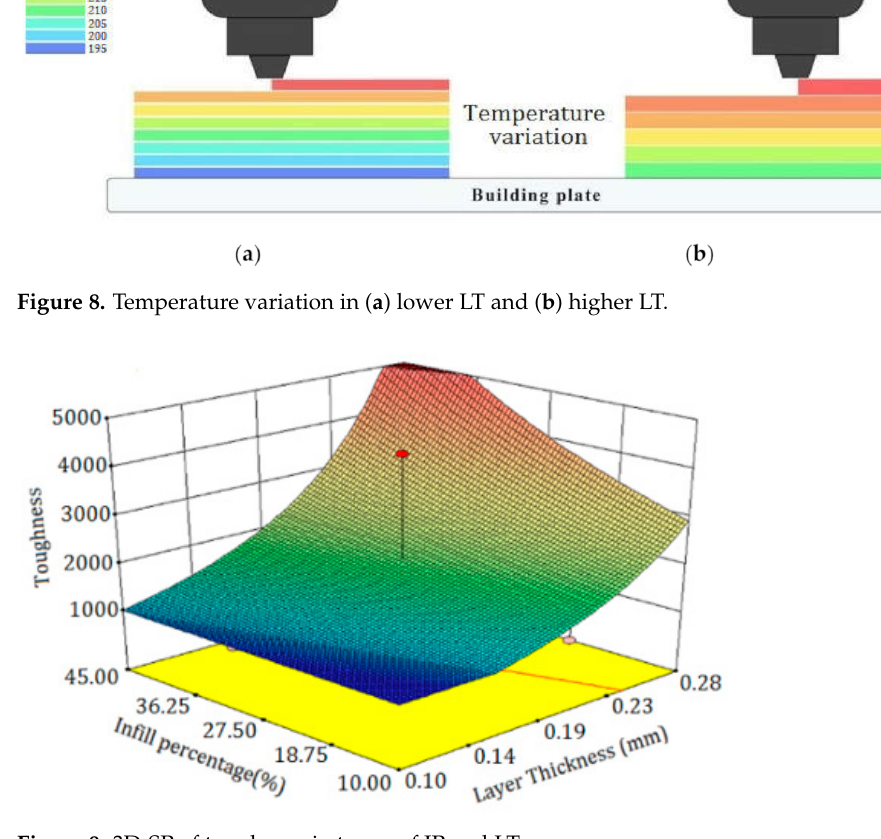
Figure 9. 3D-SP of toughness in terms of IP and LT.